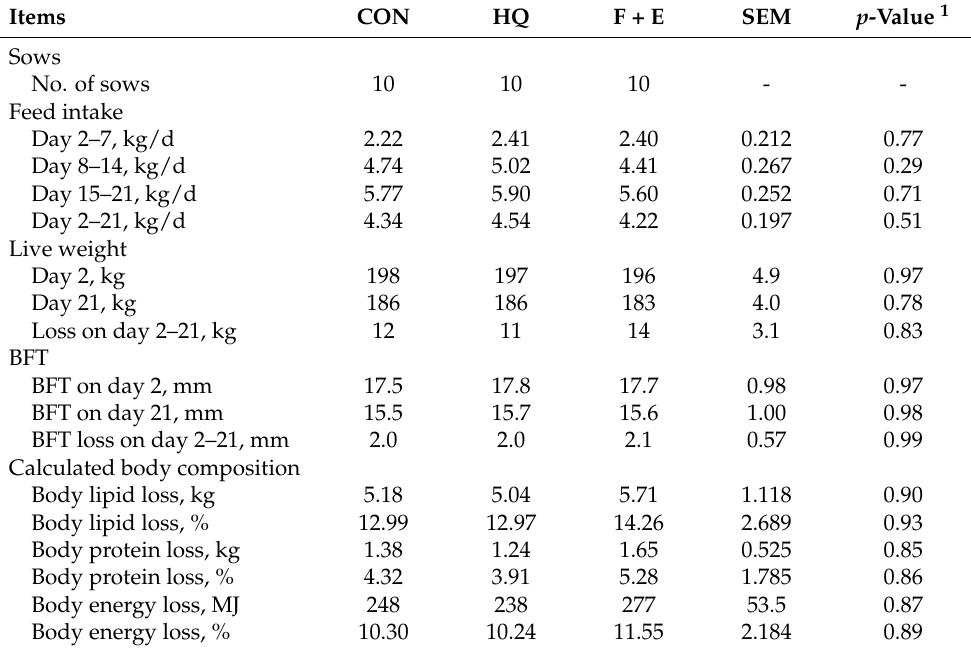
Table 2. Sow performance during the lactation period.